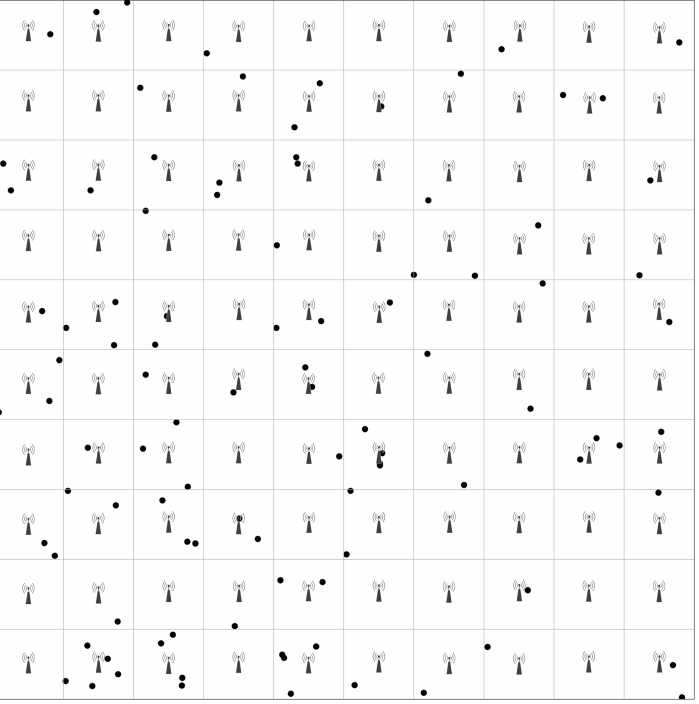
Figure 7. The default simulation environment. One-hundred APs are placed in a 100 m × 100 m area, and 100 user stations are randomly deployed inside the